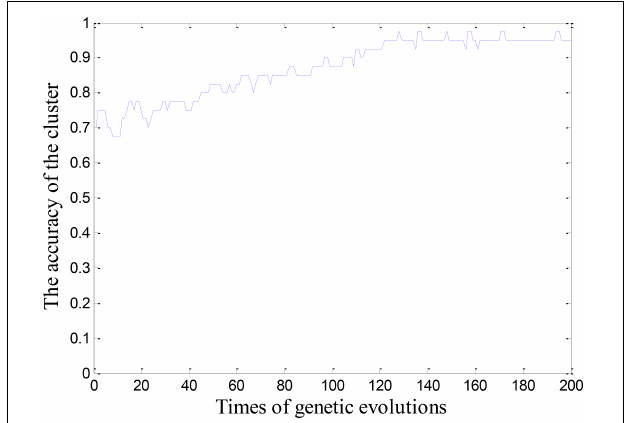
FIGURE 2 | Changes of the accuracy during the genetic evolutionary